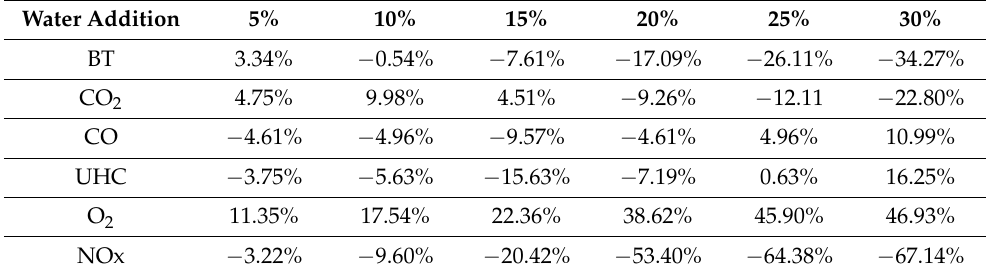
Figure 3. Effect of water-in-diesel emulsion fuel on carbon dioxide emitted from a diesel engine at different engine speed. Table 5. The average variation in engine performance and exhaust emission for varying water additions of W/D emulsion fuel compared pure diesel fuel.